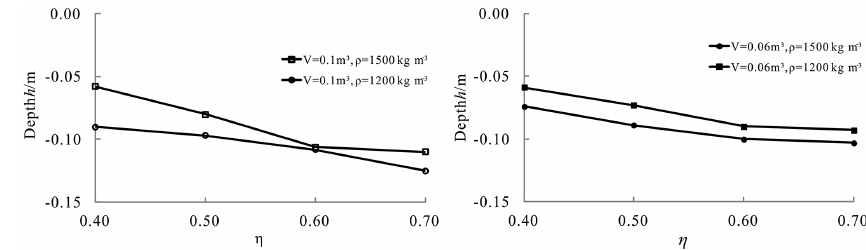
Figure 11. Comparison of scour depth at different debris-flow densities.